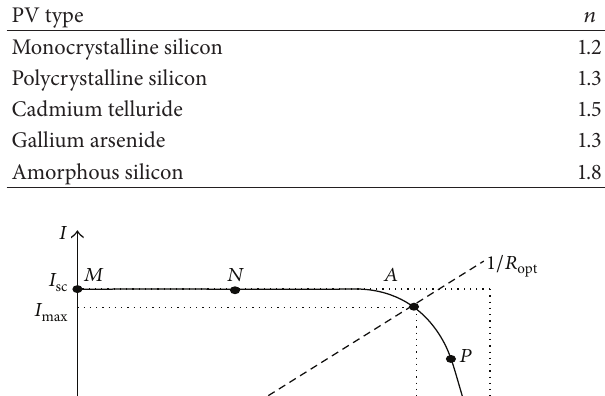
Table 2: Ideality factor of several PV types.